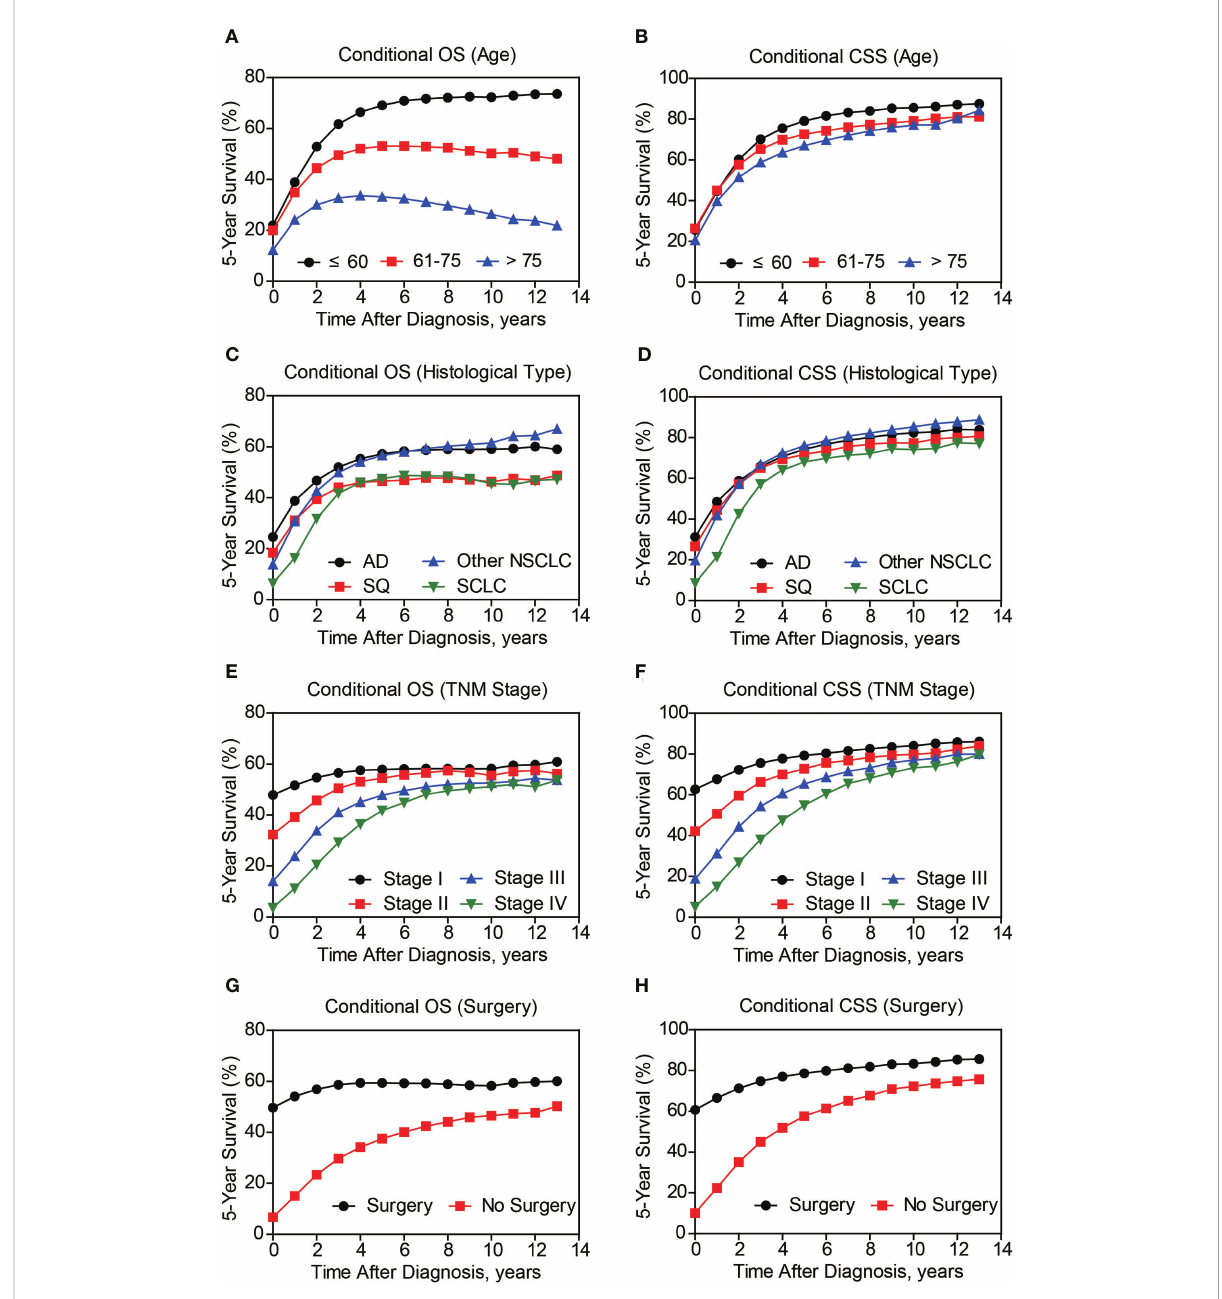
FIGURE 2 Subgroup analyses of 5-year conditional survival of lung cancer patients. The 5-year conditional overall survival (OS) and conditional cancer- speci fi c survival (CSS) analyses based on patients ’ age (A, B) , histological type (C, D) , TNM stage (E, F) , and surgical treatment (G, H)